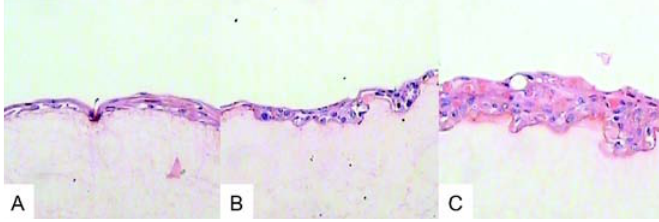
FIGURE 3 - Immerse culture situation (Light microscopy, x 400).